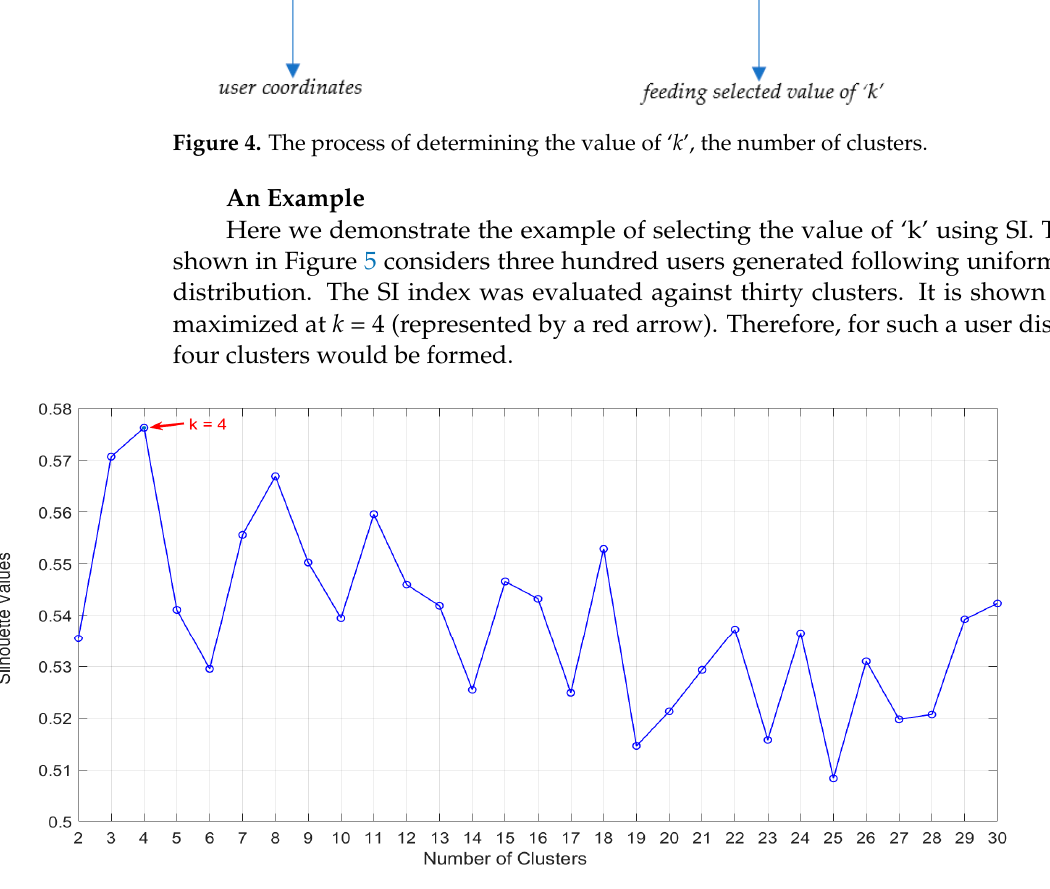
Figure 5. An example demonstrating the result of using ‘SI’ for determining the value of ‘ k